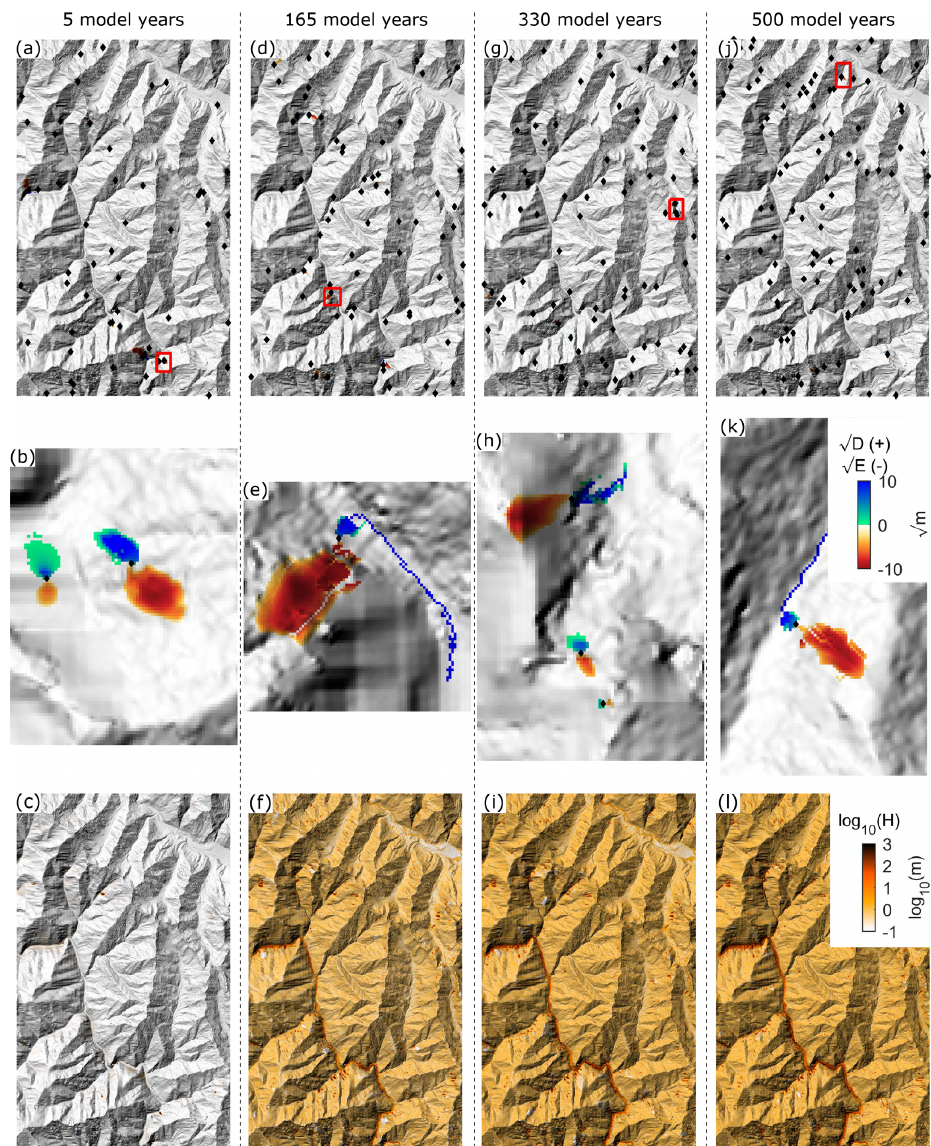
Figure 7. Time slices of HyLands model run for the Namche Barwa–Gyala Peri massif after 5, 165, 330 and 500 model years. Panels (a) , (d) , (g) and (j) indicate the location of the landslides at the given time step (black diamonds). Panels (b) , (e) , (h) and (k) zoom into the red squares in (a) , (d) , (g) and (j) showing simulated landslide erosion–deposition. The colors represent the square root (for ease of visualization) of landslide erosion ( − ) and deposition ( + ) during the presented time step. Panels (c) , (f) , (i) and (l) show the sediment thickness, H , generated through river incision (SPACE module) and landsliding. The underlying hillshade was derived from the 30m SRTM v3 DEM (Farr et al.,